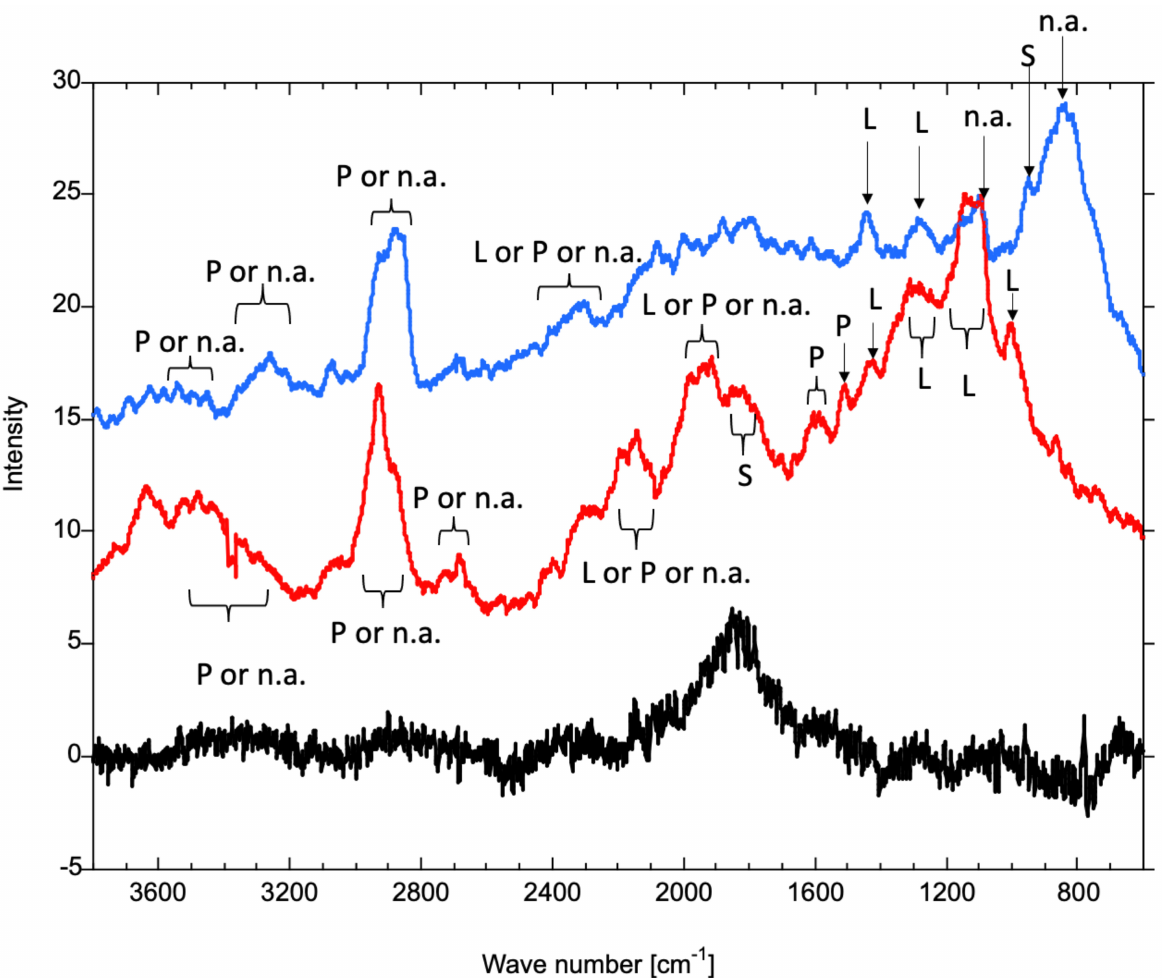
Figure 5. Raman spectra of the surface of pure aluminum samples. The black, red, and blue lines indicate the Raman spectra for iron piece prior to the tests, after LBR test, and after slowly rotating TTC test, respectively. P: proteins; n.a.: nucleic acids; h.a.: humic-like acids; L: lipids; and S: